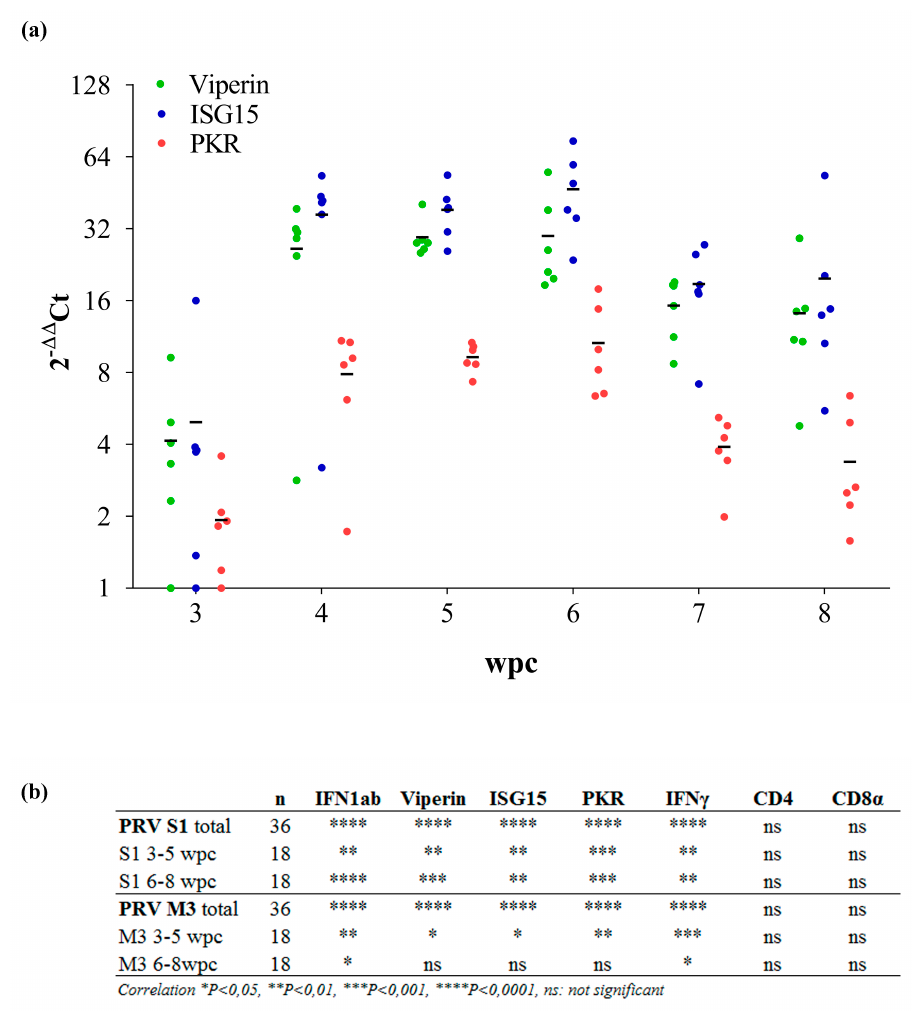
Figure 2. Expression of immune genes in blood cells. ( a ) Immune genes were assayed at 3–8 wpc by RT-qPCR in blood cells from cohabitant fish ( n = 6 per time point). Data are normalized against EF1 α and the lowest ∆ Ct level at 3 wpc ( n = 6), and 2- ∆∆ Ct values are calculated. Mean relative expression is indicated. ISG = interferon-stimulated gene, PKR = double-stranded RNA (dsRNA)-activated protein kinase; ( b ) Correlation between Ct values for S1/M3 RNA and relative levels of antiviral gene expression for a set of immune genes.